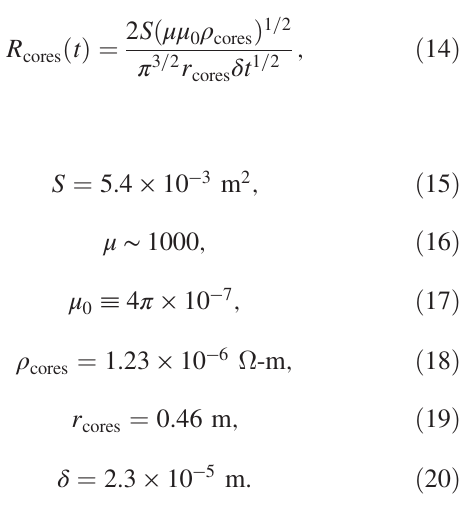
FIG. 5. Cross-sectional view of the water flare, insulator stack, and vacuum flare of the uppermost level of the six-level Z-300 insulator stack. The uppermost stack includes seven 5.72-cm-thick Rexolite-insulator rings and six 0.95-cm-thick anodized-aluminum grading